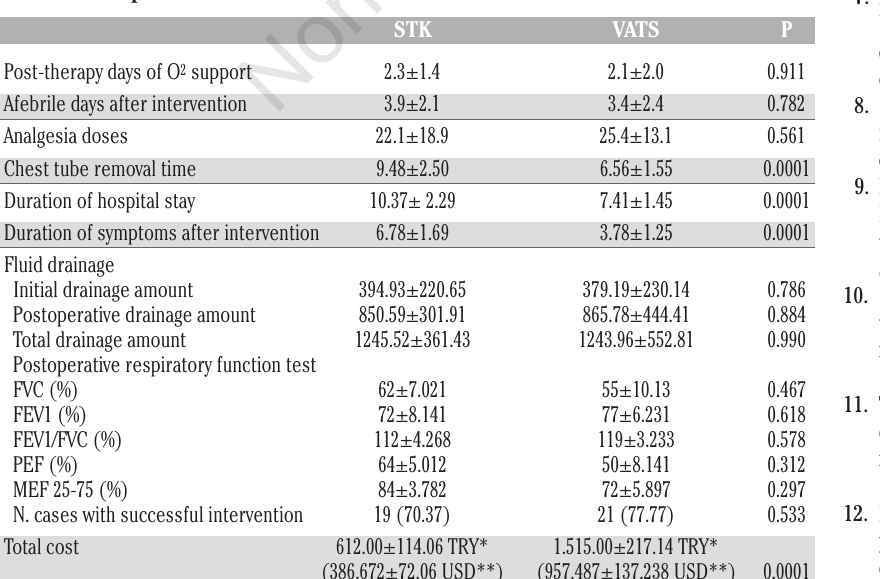
Table 4. Postoperative results of the